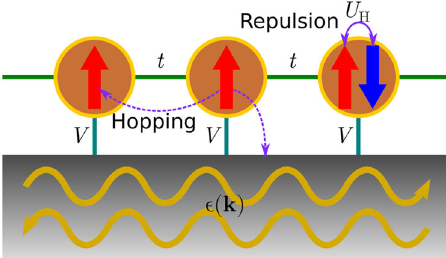
Fig. 4 Schematic representation of our physical model of emergent magnetism in substrate-supported 2D MOFs. The 2D lattice is treated within the Hubbard model with nearest-neighbour hopping t (tunable by strain) and Coulomb repulsion U H . The substrate is modelled as having plane wave states with dispersion ϵ ( k ) (derived from ab initio calculations). Coupling between the substrate and the lattice is assumed to be point-like hopping in real- space with strength V . The lattice sites have an on-site energy, which alters the electron occupation of the lattice based on its alignment with the substrate chemical